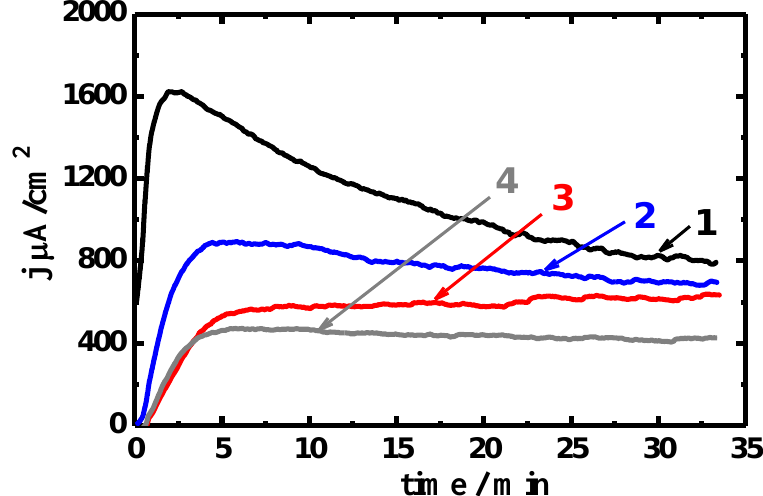
Figure 6. PCT curves gathered at -680 mV for 6061 alloys, ( 1 ) the as received and the extruded alloys at ( 2 ) 350, ( 3 ) 425, and ( 4 ) 500 °C after their immersion in 3.5% NaCl solutions for 1.0 h.